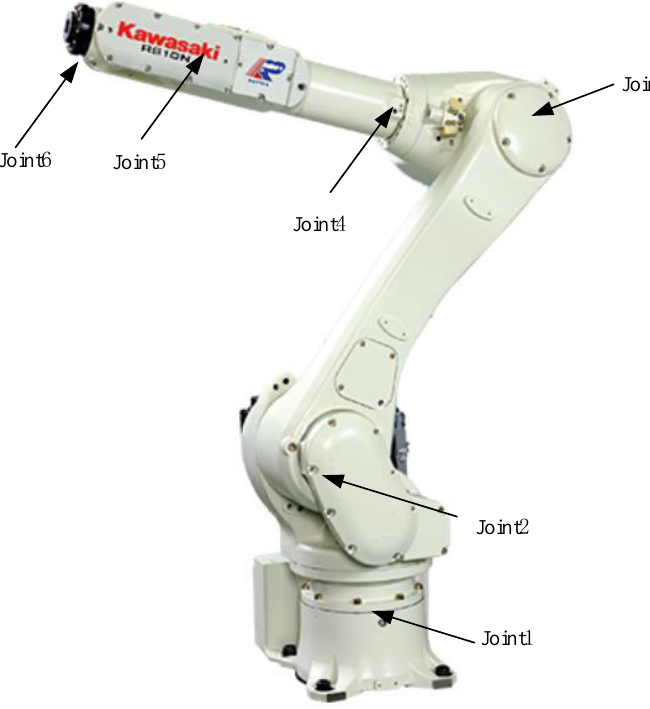
Figure 1. RS010N Figure 1. RS010N robot.